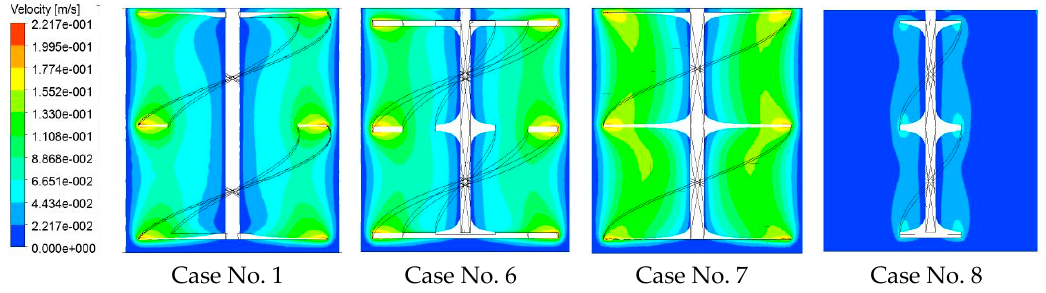
Figure 8. Velocity contours Re = 100, Z * = 0.5.